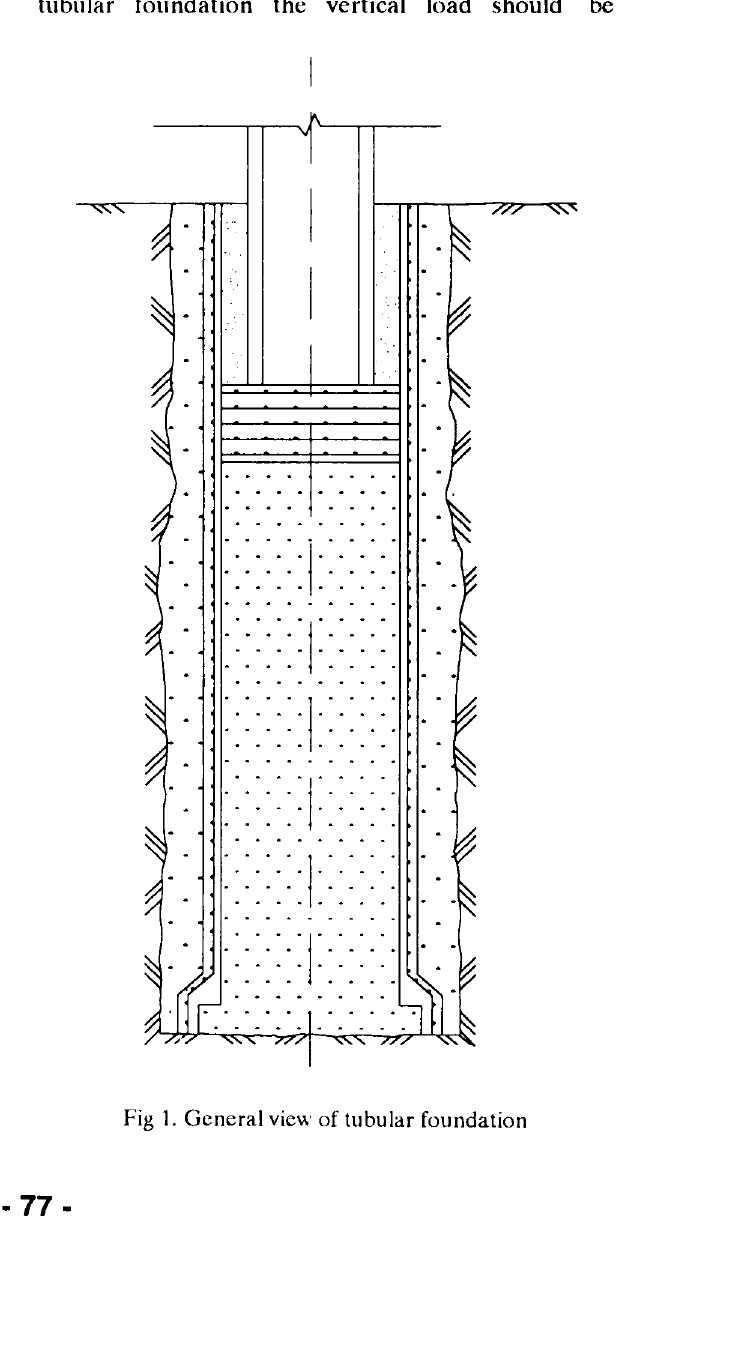
Fig 1. General view of tubular